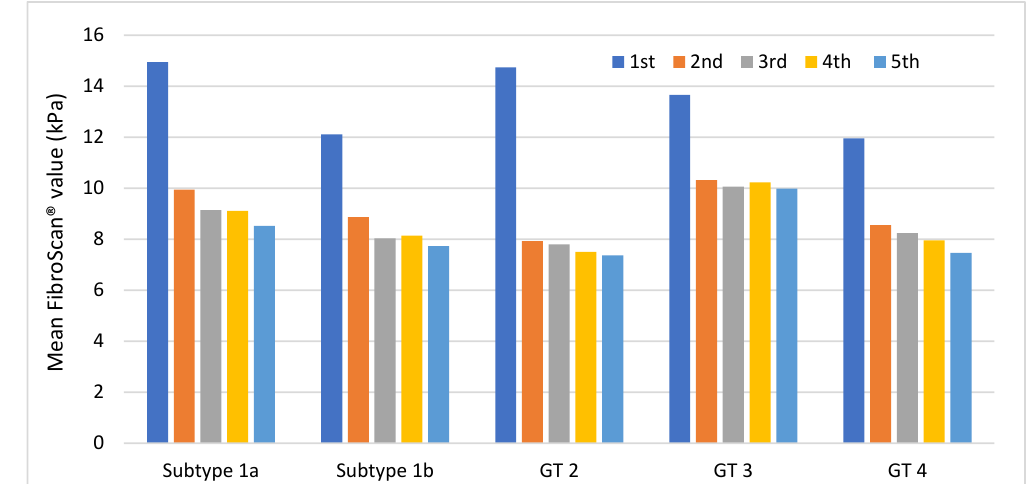
Figure 5. Trend of mean FibroScan ® values in each GT throughout the follow-up period. GT, viral genotype.